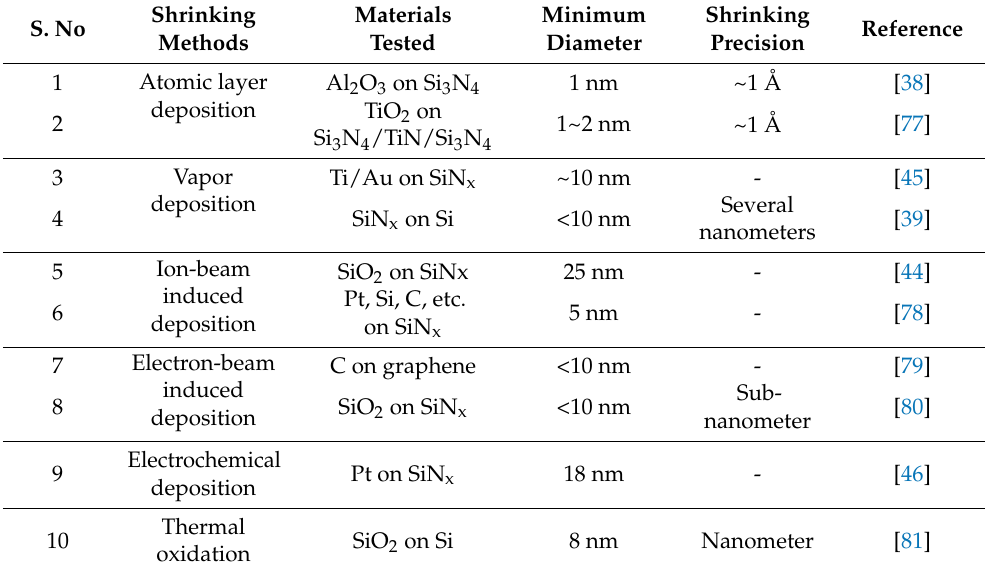
Table 2. Comparison of material deposition or